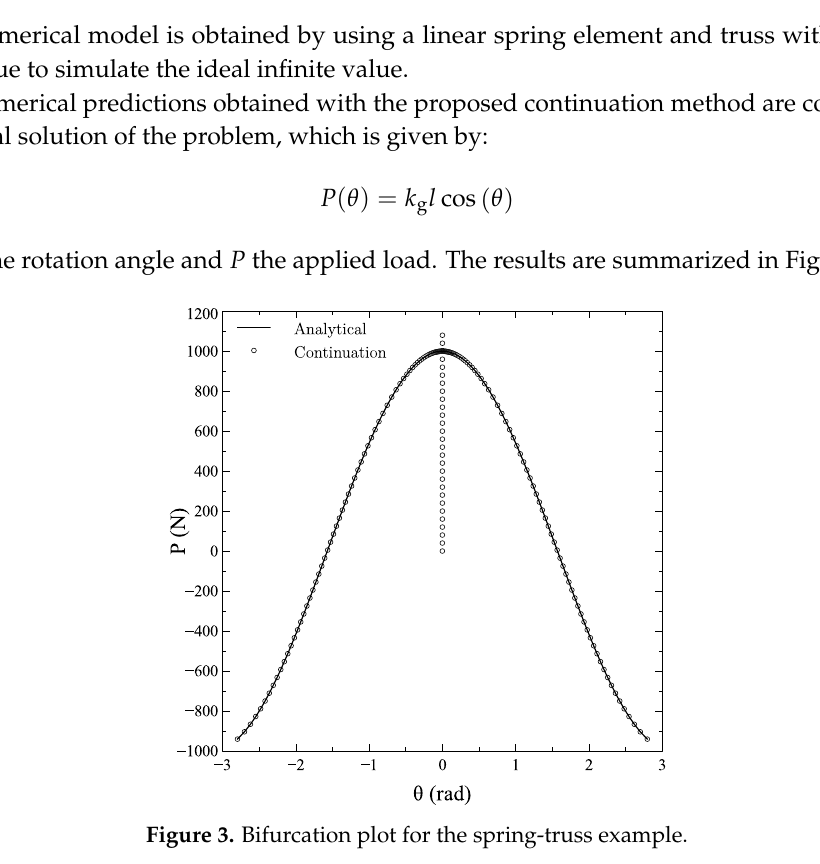
Figure 2. Sketch of the truss-spring system.